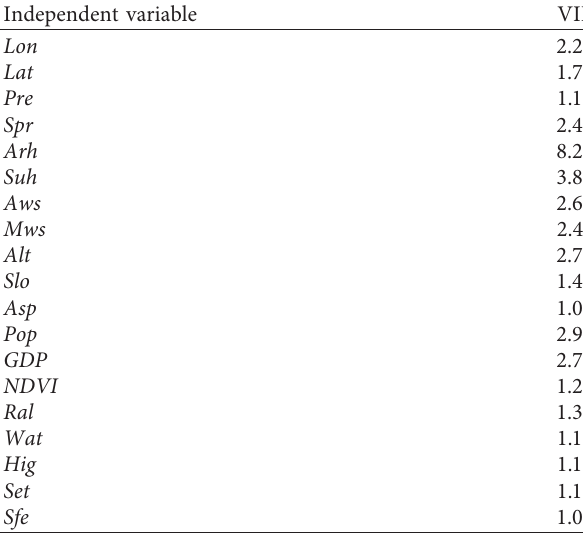
Table 4: Variable VIF values.